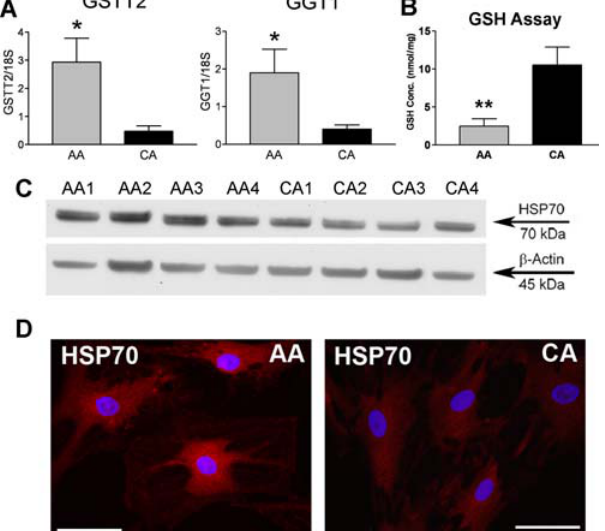
Figure 7. Differential expression of growth factors and cytokines in AA astrocytes. A. Confirmation of two differentially expressed growth factor genes by qRT-PCR in human normal ONH astrocytes: insulin-like growth factor binding protein 5 (IGFBP5) and heparin-binding EGF-like growth factor (HBEGF). Genes were normal- ized to 18S. Graphical representation of the relative mRNA levels in normal AA and CA astrocytes (n=8, respectively, two-tailed t-test was used. * indicate p , 0.05). B, C. Seven CA samples and six AA samples were used in ELISA experiment. B. The total amount of secreted and intracellular HBEGF is significantly lower in AA astrocytes compared to CA astrocytes (** indicated p , 0.01 in two-tailed t-test) C. The level of secreted IL-6 is significantly lower in AA astrocytes compared to CA astrocytes (* indicated p , 0.05 in two-tailed t-test).